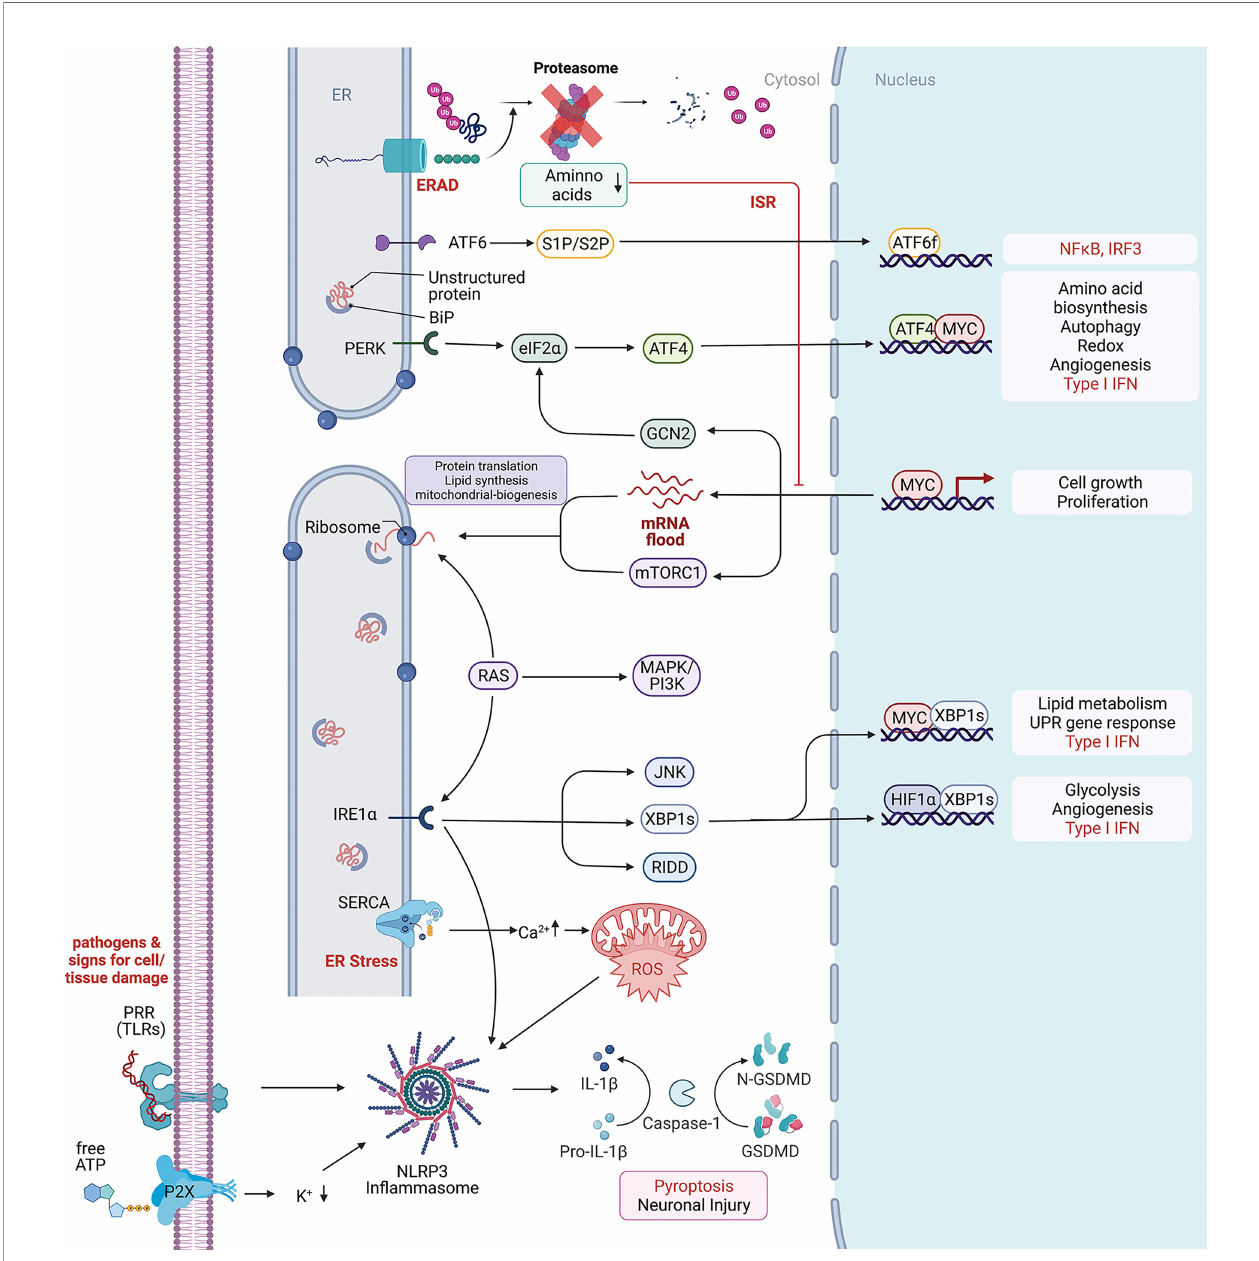
FIGURE 1 | Cellular stress response mechanism. Depicted are intracellular signaling pathways involved in the stress response against extracellular and intracellular stressors. From top to bottom: Endoplasmic-reticulum-associated protein degradation (ERAD) recognizes misfolded proteins of the endoplasmic reticulum (ER) and induces their ubiquitinylation for protein degradation through the proteasome. Low cytosolic amino acid levels can inhibit the proteasomal degradation through the proteasome and further inhibit cell growth and proliferation. Unfolded or misfolded proteins within the ER activate BiP, a major chaperone in the initiation of the unfolded protein response, that further interacts with (ATF6) and the protein kinase RNA-like endoplasmic reticulum kinase (PERK) to induce the UPR, leading to ATF6f and ATF4 dependent transcriptional modi fi cation. In rapidly proliferating cells, MYC dependent transcription enriches the cytosol with mRNAs waiting for proper translation on ribosomes. Protein folding mistakes can be recognized by the inositol-requiring enzyme 1 a (IRE1 a ), that via splicing of X-box binding protein 1 (XBP1) induces transcriptional modi fi cation and thereby lipid and glycose metabolism. The RNase domain of IRE1 mediates the cleavage of multiple RNAs in a process known as regulated IRE1-dependent decay (RIDD) (19). c-Jun N-terminal kinase (JNK) activation may be linked to ER stress by IRE1 and autophagy induction after ER stress relies on the IRE1-JNK pathway (20). The ER is highly involved in calcium homeostasis by acting as a calcium storage. Ion-pumps like the sarco/endoplasmic reticulum Ca2+-ATPase (SERCA) are actively transporting calcium between the cytosol and ER lumen. High cytosolic calcium concentration can increase the production of reactive oxygen species (ROS) that further are able to promote NLR family pyrin domain containing 3 (NLRP3) in fl ammasome activation which is usually activated by exogenous pathogens, recognized by their RNA/DNA on pattern recognition receptors (PRR) like Toll-like receptors (TLR) and the involved tissue damage products like ATP that can be recognized by purinergic receptors like P2R. Created with